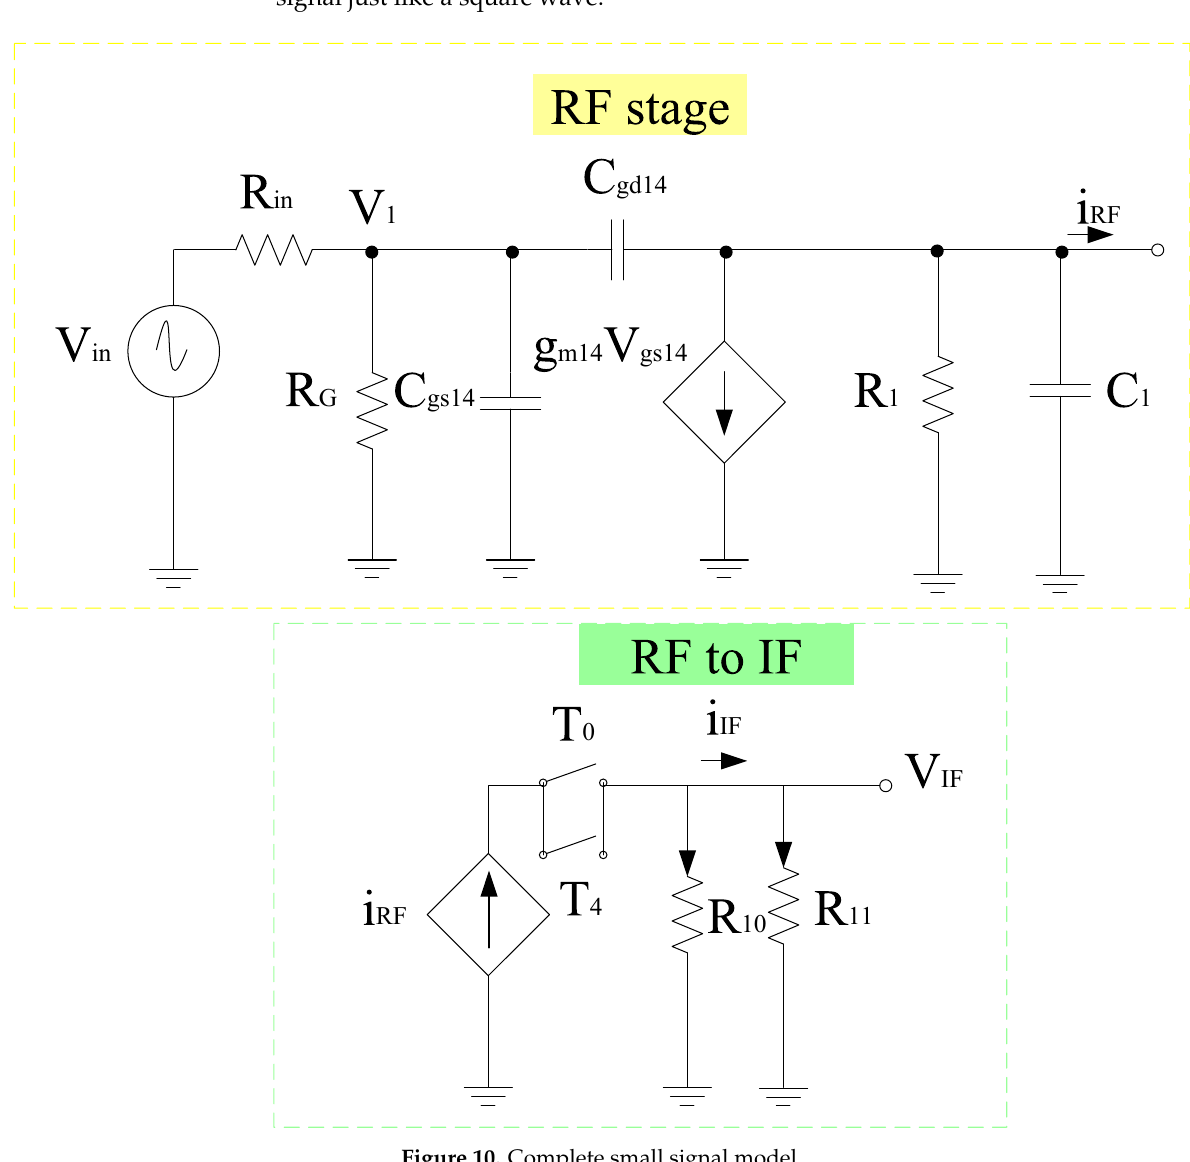
Figure 10. Complete small signal